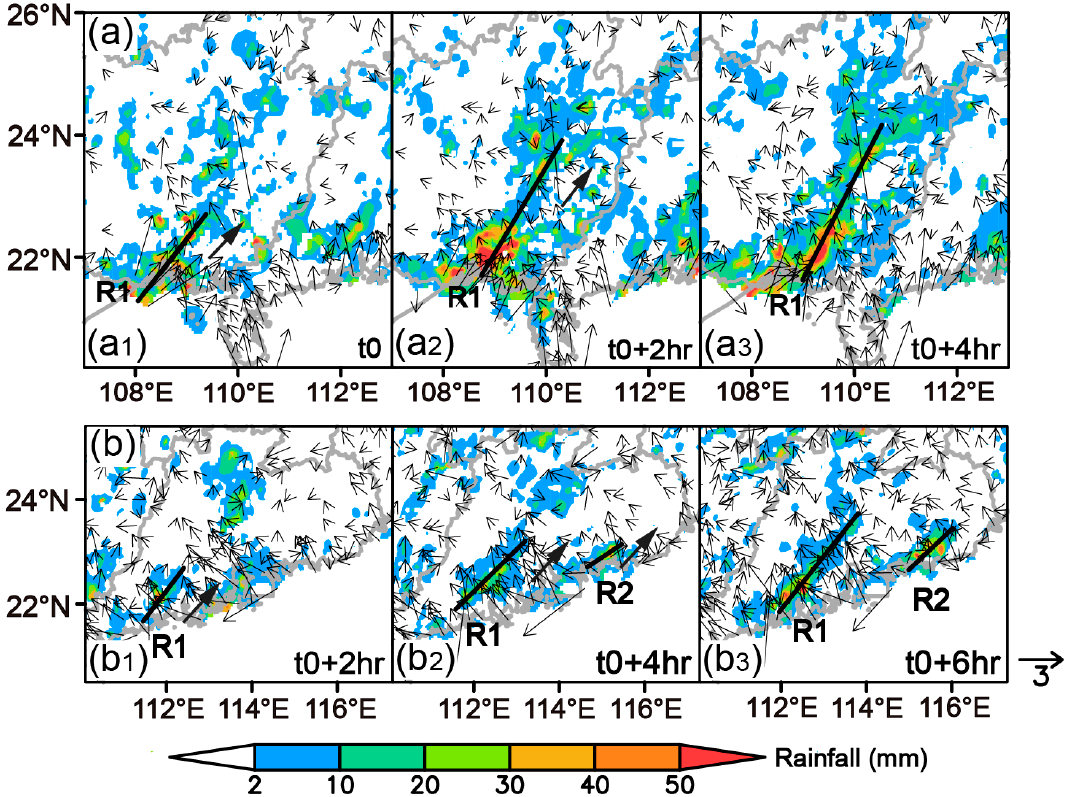
Figure 13. Evolution of composite cumulative rainfall distributions (color-shaded; units: mm) and near-surface wind vectors (units: m s − 1 ) under the vertical wind profile of WP1-2 in the SWLLJ situation. The lines (“R1” and “R2”) and arrows indicate rainfall belts and their approximate motion directions, respectively. “t0” and “t0 + x h” indicate the initial time of rainfall and “x” hours after. “ a , a 1 – a 3 ” and “ b , b 1 – b 3 ” show the evolution of the rainfall distributions and near-surface wind vectors near the coastal areas of Guangxi and Guangdong Province.